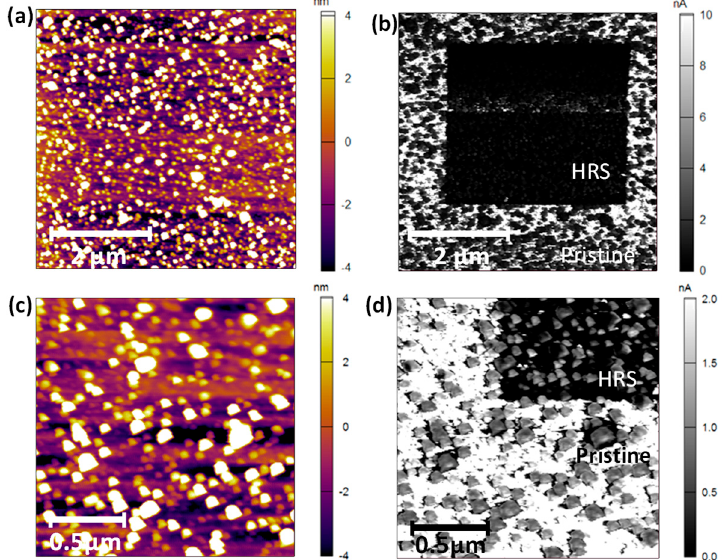
Figure A3. Switching of a 3 × 3 µ m 2 area of a LNMO film into the HRS. ( a ) Topography and ( b ) current map images of a 5 × 5 µ m 2 area, where the central 3 × 3 µ m 2 has been previously scanned at − 4 V of sample Voltage. The current map shows a switching to the HRS of the LNMO film in the scanned area, which does not induce any changes in the topography. ( c ) Topography and ( d ) Current map images of a detailed area (2 × 2 µ m 2 ) showing the lack of switching of NiOx particles that are more resistive than the film in the pristine state but more conductive than the film in the